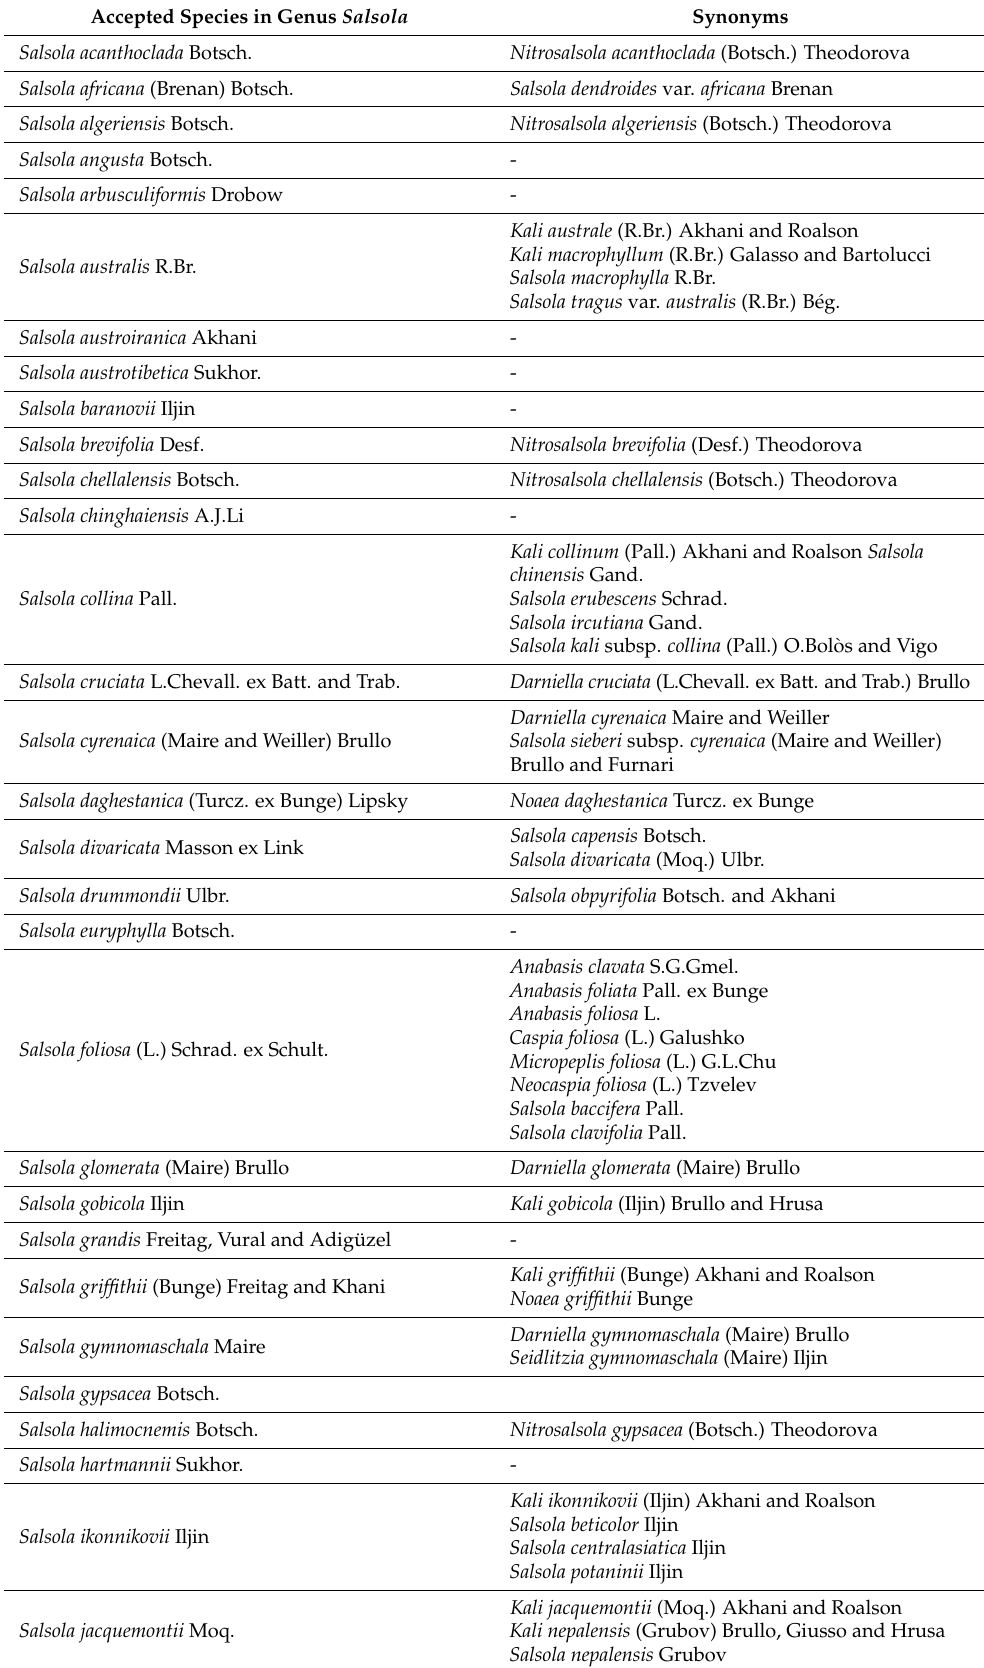
Table 1. List of accepted species in genus Salsola and their synonyms